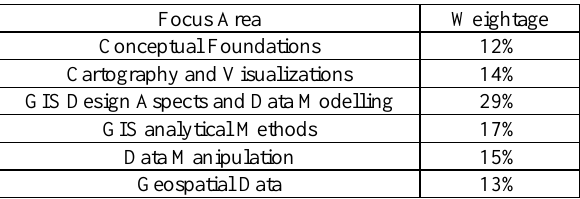
Table 1: List of examination areas (source: Somers